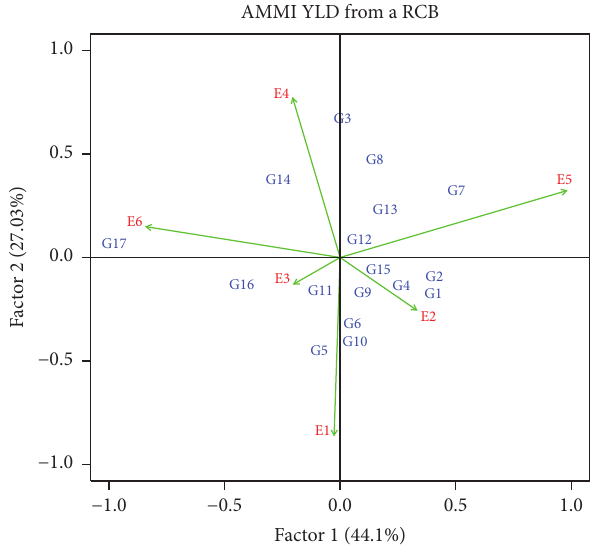
Figure 1: AMMI biplot of IPCA1against IPCA2 for bean yield of 17 coffee genotypes tested at six environments. Note: E1 � Teppi1, E2 � Gemadro1, E3 � Godare1, E4 � Teppi2, E5 � Gemadro2, E6 � Godare2. G1 � 3/82, G2 � 28/82, G3 � 29/82, G4 � 32/82, G5 � 37/82, G6 39/82, G7 � 42/82, G8 � 44/82, G9 � 45/82, G10 � 48/82, G11 � 235/71A, G12 � 17/79, G13 � 20/79, G14 � 22/79, G15 � Catimor J-19, G16 � Catimor J-21, and G17 �